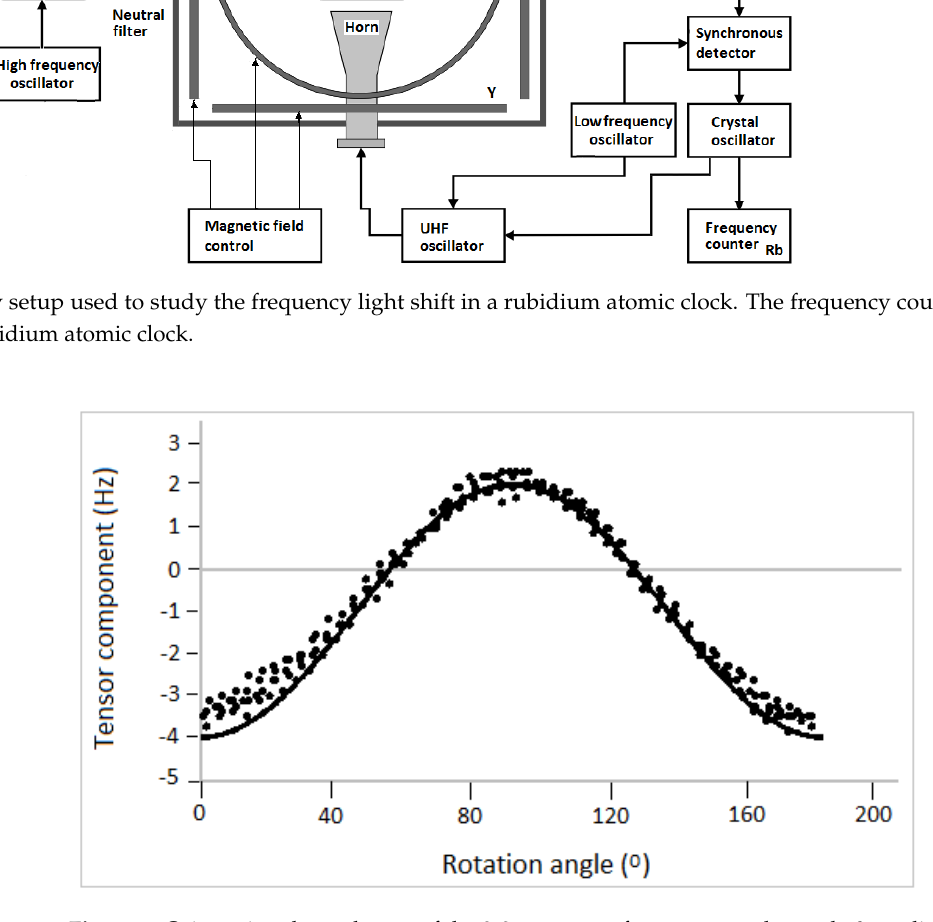
Figure 2. Orientation dependences of the 0-0 resonance frequency on the angle θ at a light intensity of 100 µ W/cm 2 (the dots indicate the experimental values of the orientational shift) [7]. The data (obtained in the experiment) correspond to the relative frequency light shift of atomic standards on rubidium vapor at a level of ~10 −9 . Thus, in order to ensure the relative frequency instability at the level of 10 −13 , it is necessary to ensure the stability of the pump source intensity not worse than 0.01%, which corresponds to the conclusions of [8–10]. In order of magnitude, the above value of the relative light shift (~10 −9 ) is com- parable to the regular correction (4 × 10 −10 ) associated with the gravity influence in ac- cordance with formula (1). However, such a shift does not take into account the change of the onboard atomic clock frequency associated with the variation angle 𝜃 when the sat- ellite moves in orbit. Under the operating conditions of the onboard rubidium atomic clock, the presence of a magnetic screen significantly reduces the angle variation 𝜃 be- tween the atomic clock optical axis and the operating magnetic field direction. These var- iations are caused not only by a change in the magnitude and direction of the external geomagnetic field when the satellite moves in orbit, but also by a significant difference in the axial and transverse screening coefficients of the magnetic screen [11]. On the other hand, the absolute value of the geomagnetic field at the satellite orbit (with a strength of less than 0,6 A/m) is almost two magnitude orders less than the field strength on the planet's surface, which significantly reduces the efficiency of magnetic screening due to the weakening of the screen material magnetic permeability as the external magnetic field decreases. As in the experiments shown with a laboratory rubidium atomic clock, the ori- entational frequency shift value does not depend on the strength of the external magnetic field but is determined by the pumping rate and the atomic clock orientation in the geo- magnetic field [7]. This orientation change when the satellite moves in orbit should inev- itably lead to orientation errors in real onboard atomic clocks. To verify this statement in authors experiments, authors used two commercial small-sized atomic clocks on rubid- ium vapor (No. 1 and No. 2), manufactured by Frequency Electronics (model FE-5650A). The Allan deviation value of these devices during the averaging time of 100 s is less than 1.4 × 10 −12 . The laboratory setup used to investigate the orientational frequency shift of the ru- bidium atomic clock is represented in Figure 3.